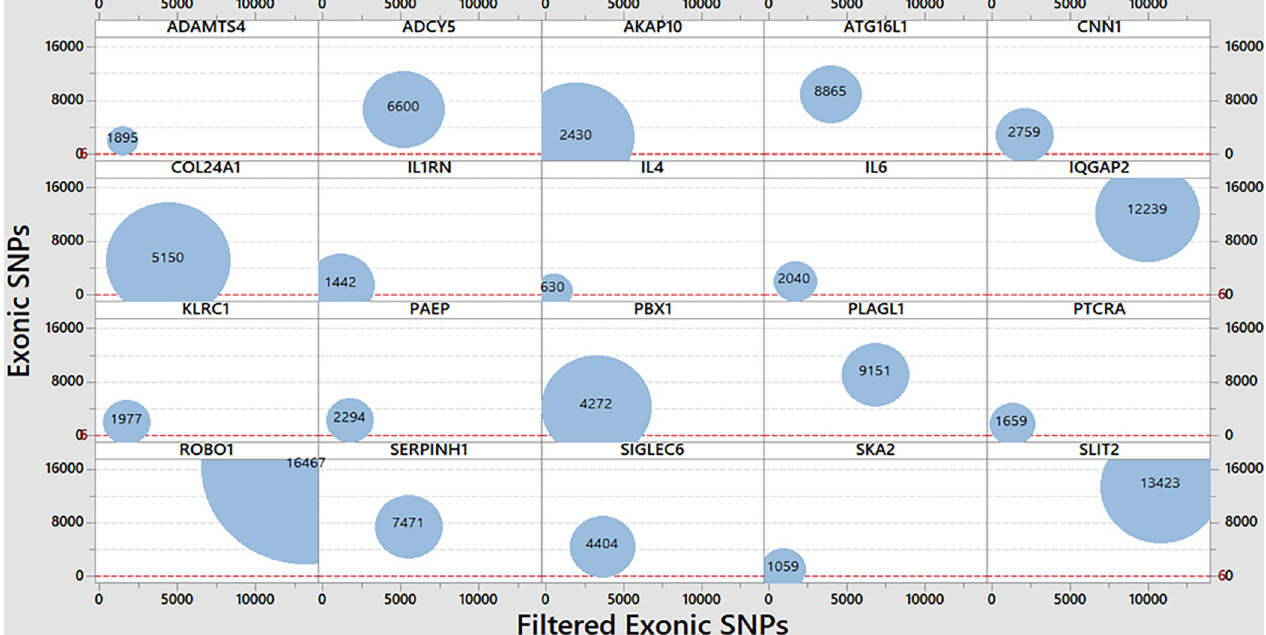
Fig 2. SNPs in the identified PTB-related genes. Bubble plot showing identified PTB-gene wise SNPs, exonic-SNPs and filtered exonic-SNPs. Each bubble size stands for the total count of SNPs.